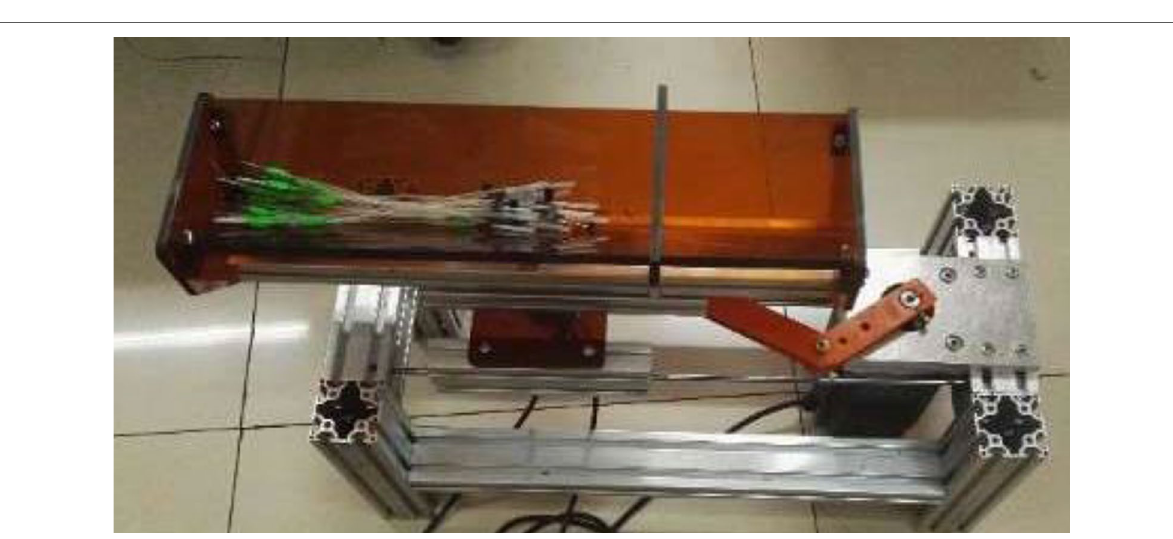
Figure 7 Automatic material tidying test